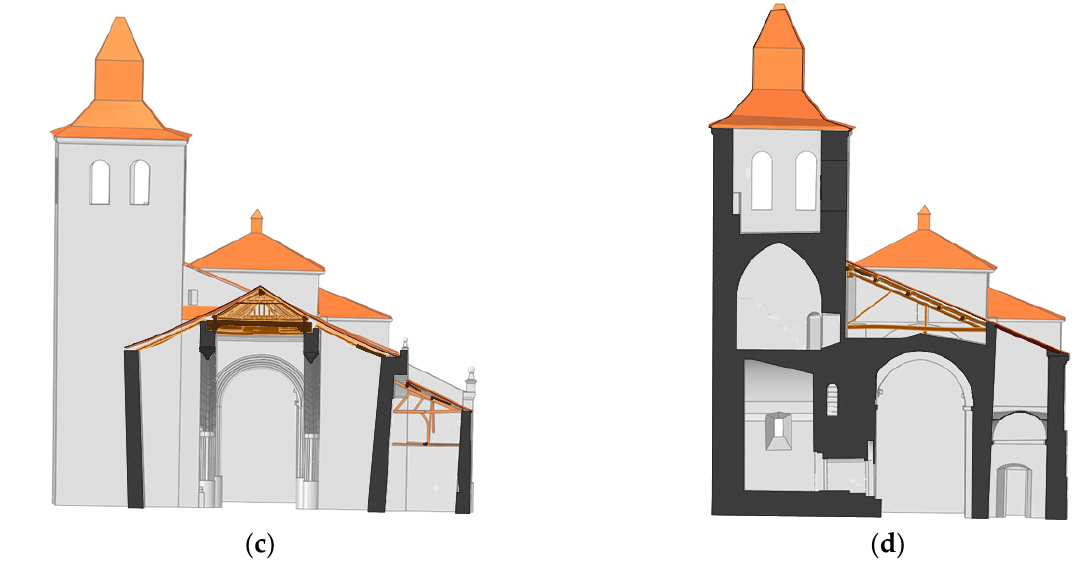
Figure 11. Final CAD 3D model: ( a ) general view on which it is possible to see the general geometry of the church, as well as the deformations of the roof; ( b ) plant view from the bottom to the top of the church; ( c ) cross-section along the naves; ( d ) cross-section along the tower. In grey are the masonry elements, in orange are the estimated positions of the ceramic tiles and in brown is the timber structure.